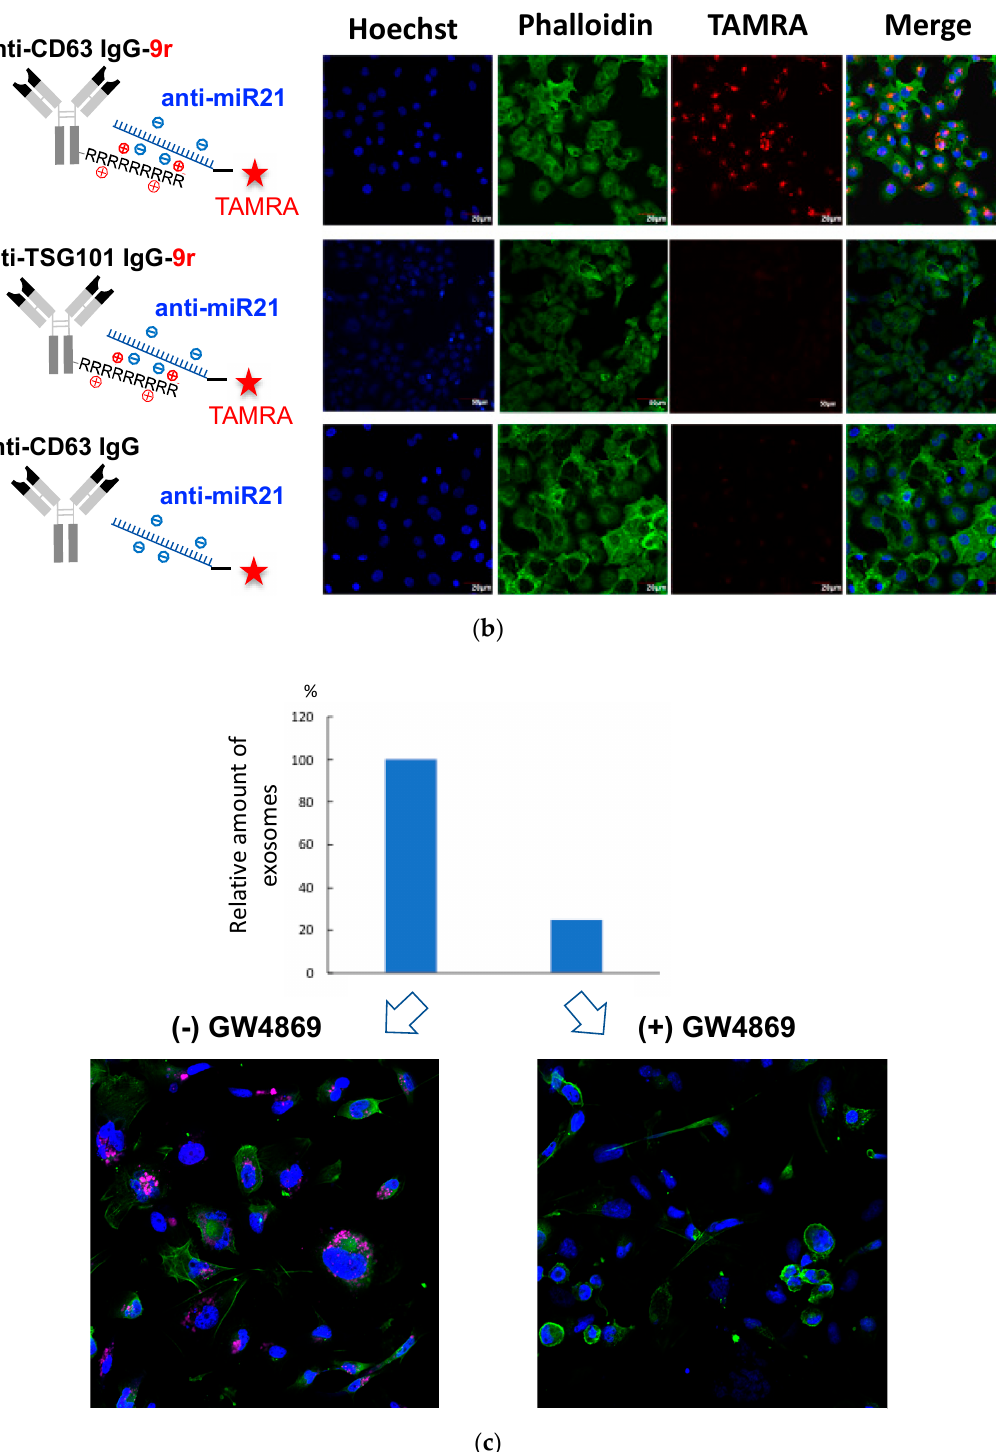
Figure 3. Successful incorporation of ExomiR-Tracker into the recipient cells: ( a ) The synthetic scheme of ExomiR-Tracker. ( b ) Cellular localization of ExomiR-Trackers with TAMRA-labeled anti-miRs. ( c ) Number of exosomes produced by Cal27 cells after GW4869-treatment (above) and the cellular uptake of ExomiR-Trackers with TAMRA-labeled anti-miR oligonucleotides.